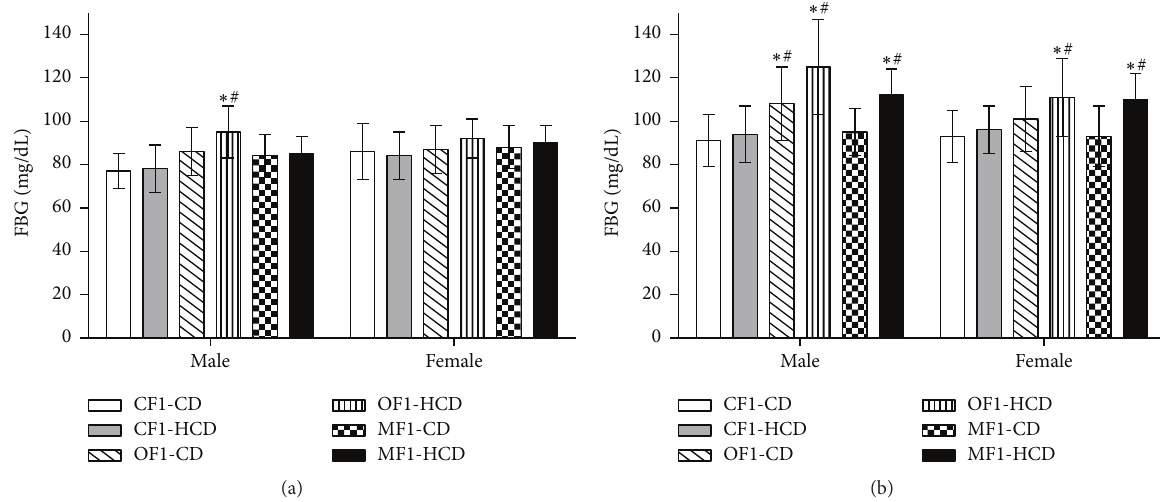
Figure 1: Fasting blood glucose (FBG) levels (mg/dL) of all study groups at (a) week 5 and (b) week 30 of age. Data are presented as mean ± SD ( 𝑛 = 10 ). CF1-CD: F1 offspring of control mothers under control diet, CF1-HCD: F1 offspring of control mothers under high-caloric diet, OF1-CD: F1 offspring of obese mothers under control diet, and OF1-HCD: F1 offspring of obese mothers under high-caloric diet; MF1-CD: F1 offspring of malnourished mothers under control diet and MF1-HCD: F1 offspring of malnourished mothers under high-caloric diet. The symbol ∗ indicates significant difference from CF1-CD by ANOVA ( 𝑝 < 0.05 ) and the symbol # indicates significant difference from CF-HCD by ANOVA ( 𝑝 < 0.05 ).